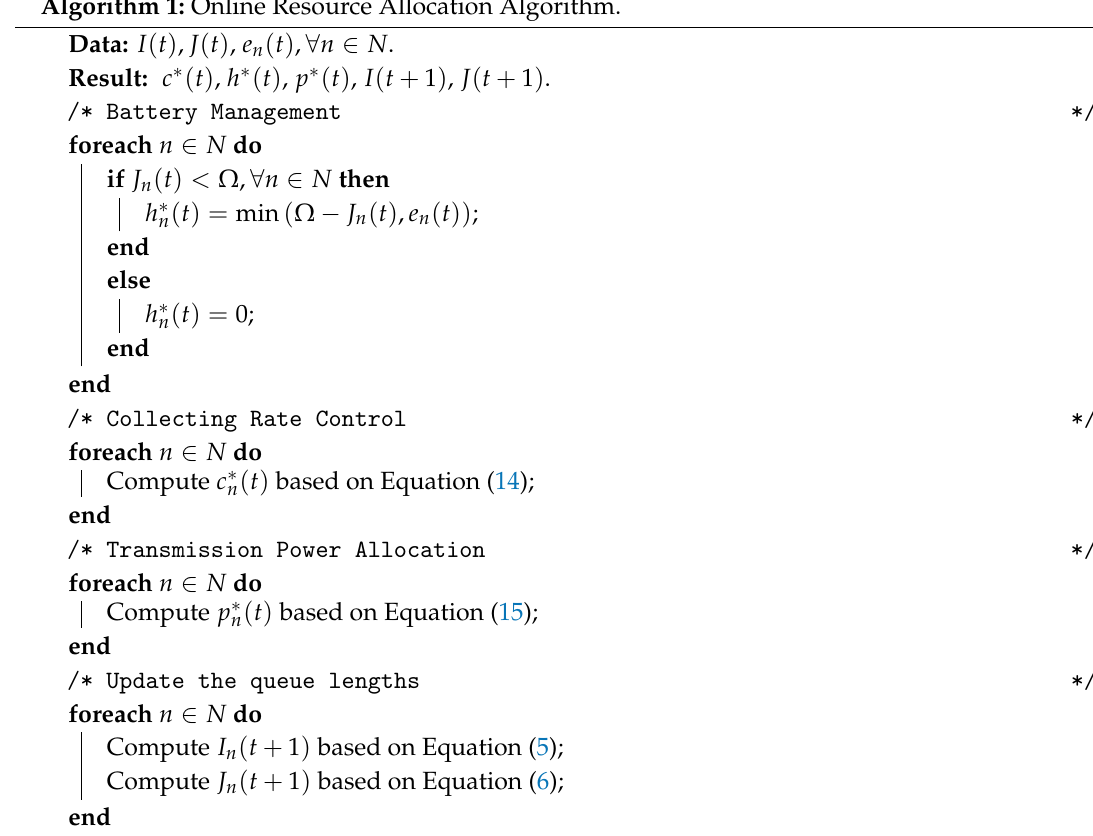
Algorithm 1: Online Resource Allocation